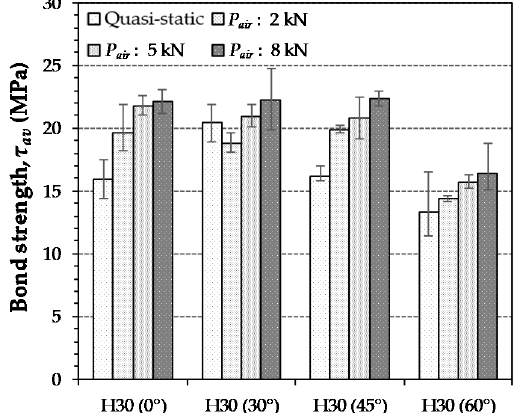
Figure 12. E ff ects of loading rate and inclination angle on average bond strength of H-fibers in UHPC (Note: P air = air pressure).